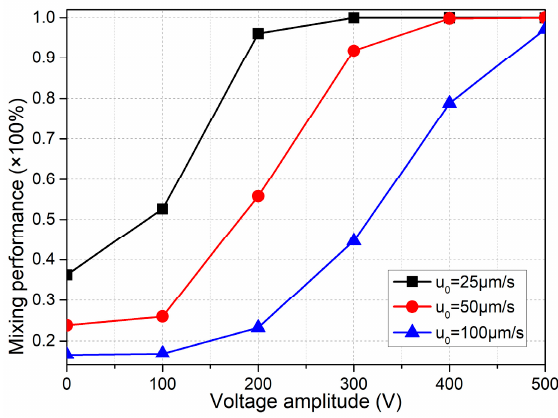
Figure 11. Voltage-dependent mixing performance for different inlet flow velocity, in which the applied electric field strength is no more than E 0 = 2500 V/cm.